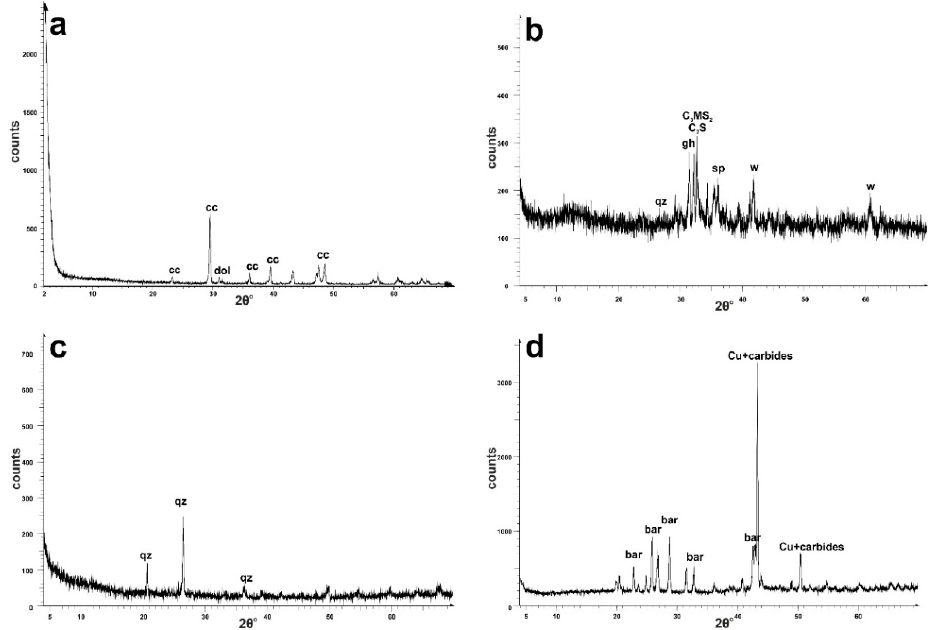
Figure 4. X ‐ ray diffraction patterns of the studied raw materials: ( a ) limestone (sample S1B); ( b ) slag